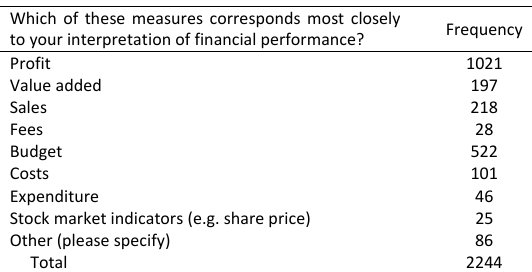
Table 4: Interpretation of “Financial performance” Which of these measures corresponds most closely to your interpretation of financial performance?